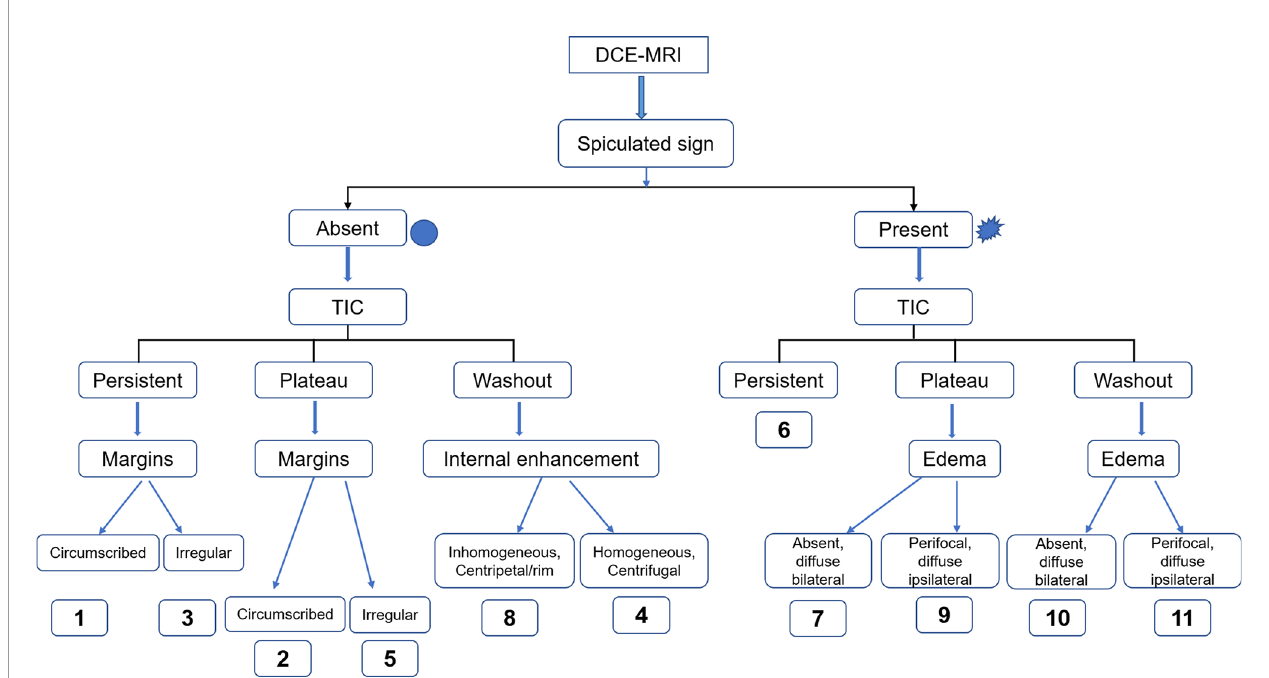
FIGURE 2 | The fl owchart of Kaiser score. This fl owchart was adapted from a Ref (13). Kaiser score insists of 11 rating categories ranging from 1 to 11, and each of these scores corresponds to a distinct likelihood of malignancy (13). If the score exceeds 4, a biopsy is recommended (8, 9). DCE-MRI, dynamic contrast- enhanced MRI; TIC, time – signal intensity